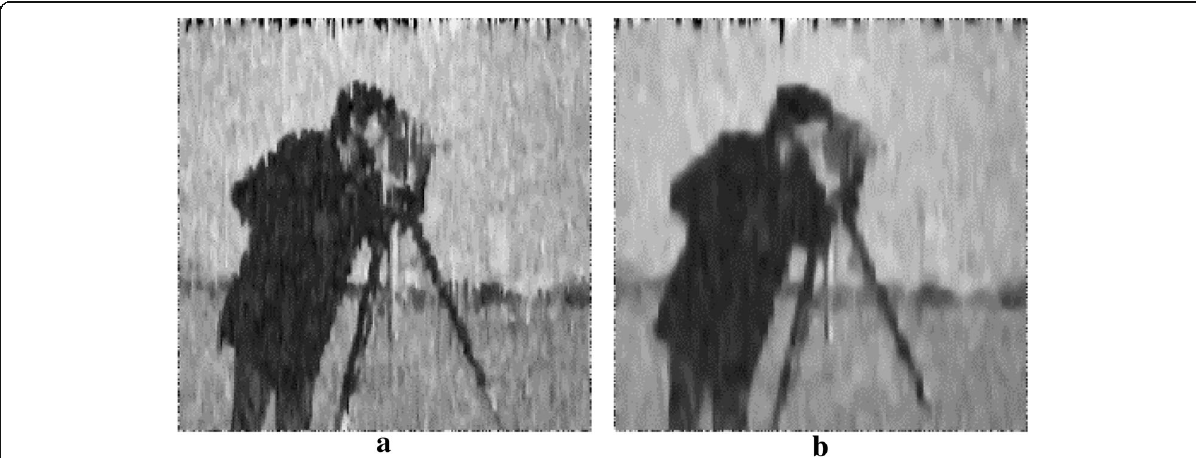
Fig. 6 Performance of FORADF ( λ =1) for very high-density mixed noise a at n =5 and b n =25. λ represents the control parameter, and n represents the number of iterations. The results are given for very high-density mixed noise, i.e., Gaussian noise of variance 0.1 plus salt and pepper noise of density